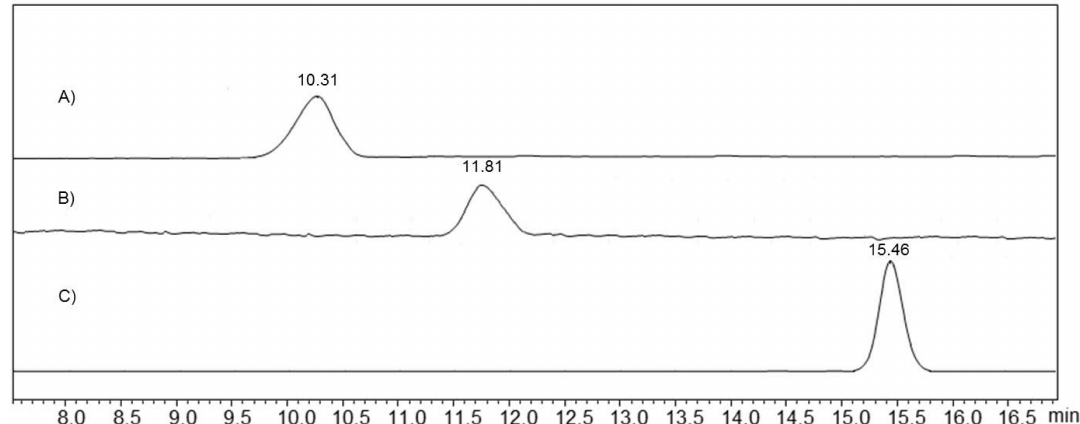
Figure 4. Gel permeation chromatography (GPC) chromatograms of multicalix[4]arenes 6 , 7 and macrocycle 5 ( A ) multithiacalix[4]arene 6 ; ( B ) multithiacalix[4]arene 7 ; ( C ) thiacalix[4]arene 5